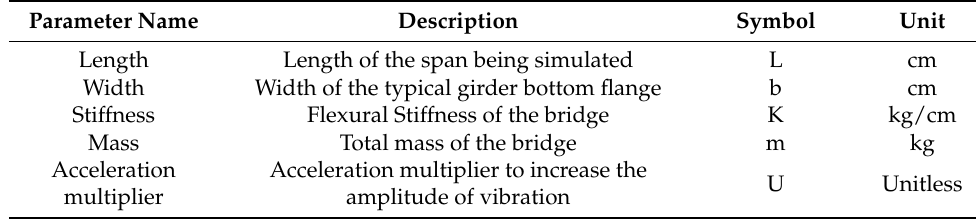
Table 4. Numerical model input parameters. Plate